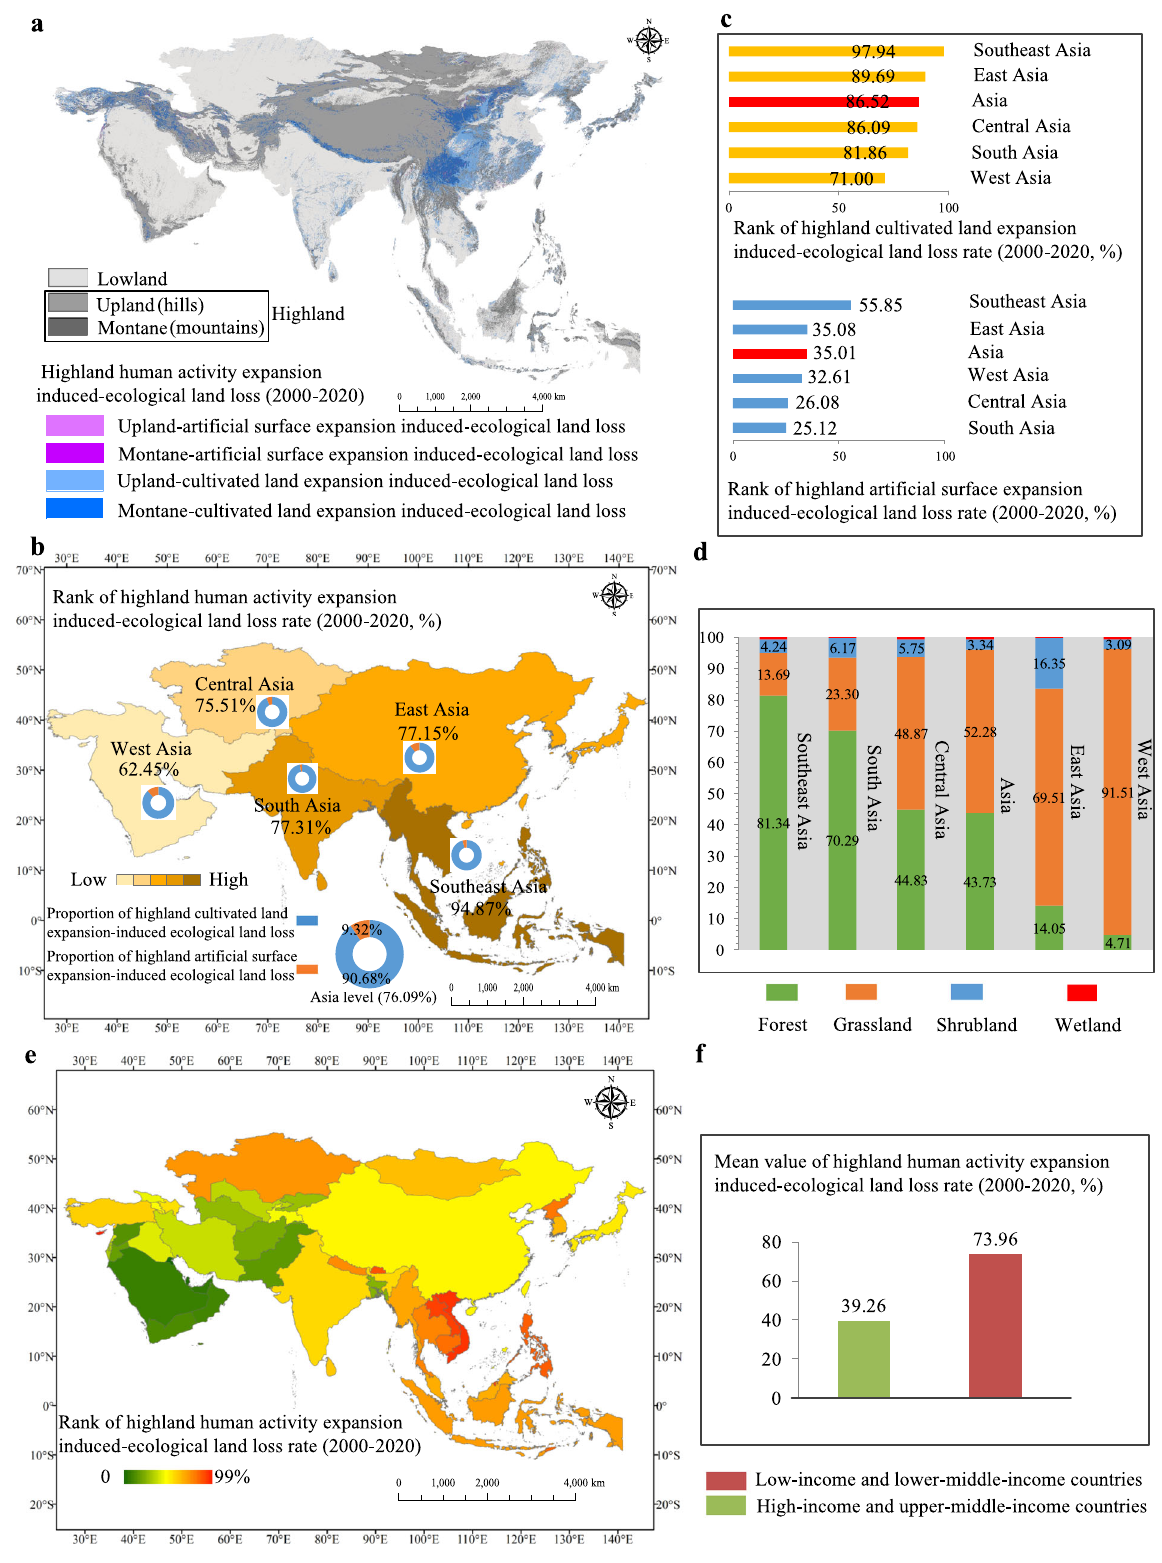
Fig. 3 | Quanti fi cation of ecological land loss in highlands induced by human activity expansions in Asia from 2000 to 2020. a Spatial distribution of ecolo- gical land loss induced by human activity expansions, b rank of human activity expansion rate, c rank of human activity expansion rates considering cultivated